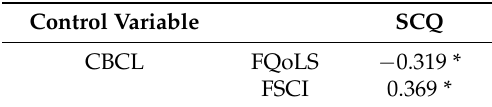
Table 3. Partial correlations controlling for challenging behaviour